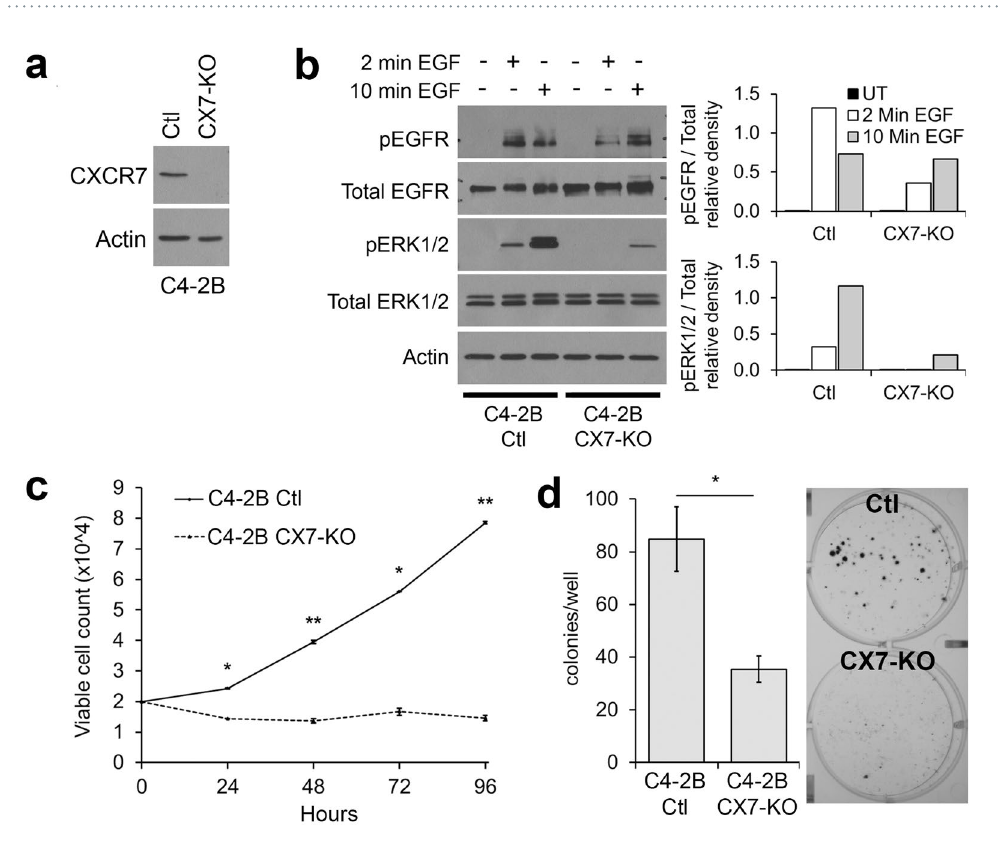
Figure 4. CRISPR-Cas9 deletion of CXCR7 inhibits cell proliferation and suppresses mitogenic signaling. ( a ) Western blot confirmation of CXCR7 protein knockout in C4-2B cells. ( b ) Western blots of EGFR and ERK1/2 activation in Ctl and CX7-KO cells, and densitometry showing relative phosphorylated protein to total protein. ( c ) Viable cell count for Ctl and CX7-KO cells (n = 2, mean ± SEM). ( d ) Left: Clonogenic survival assay results displaying a mean count of colonies obtained per well for each cell line. Right: representative image of Ctl and CX7-KO established colonies (n = 3, mean ± SEM). * p < 0.05, ** p < 0.01; unpaired, two-tailed Student’s t-test. The western blots are representative of two independent experiments with similar outcomes; densitometry is measured from the western blot panel